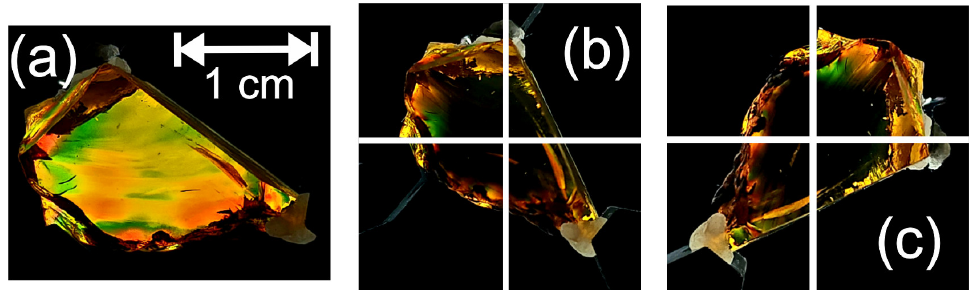
Figure 4. Visual birefringence images of the Lebanese amber specimen. ( a ) Crossed polarization image showing birefringence at an arbitrary angle. ( b , c ) Images showing minimum transmission for two orientations of the sample relative to the crossed polarizers. The transmission axes of the polarizers are parallel and perpendicular to the bottom of the page, as indicated by the white lines.